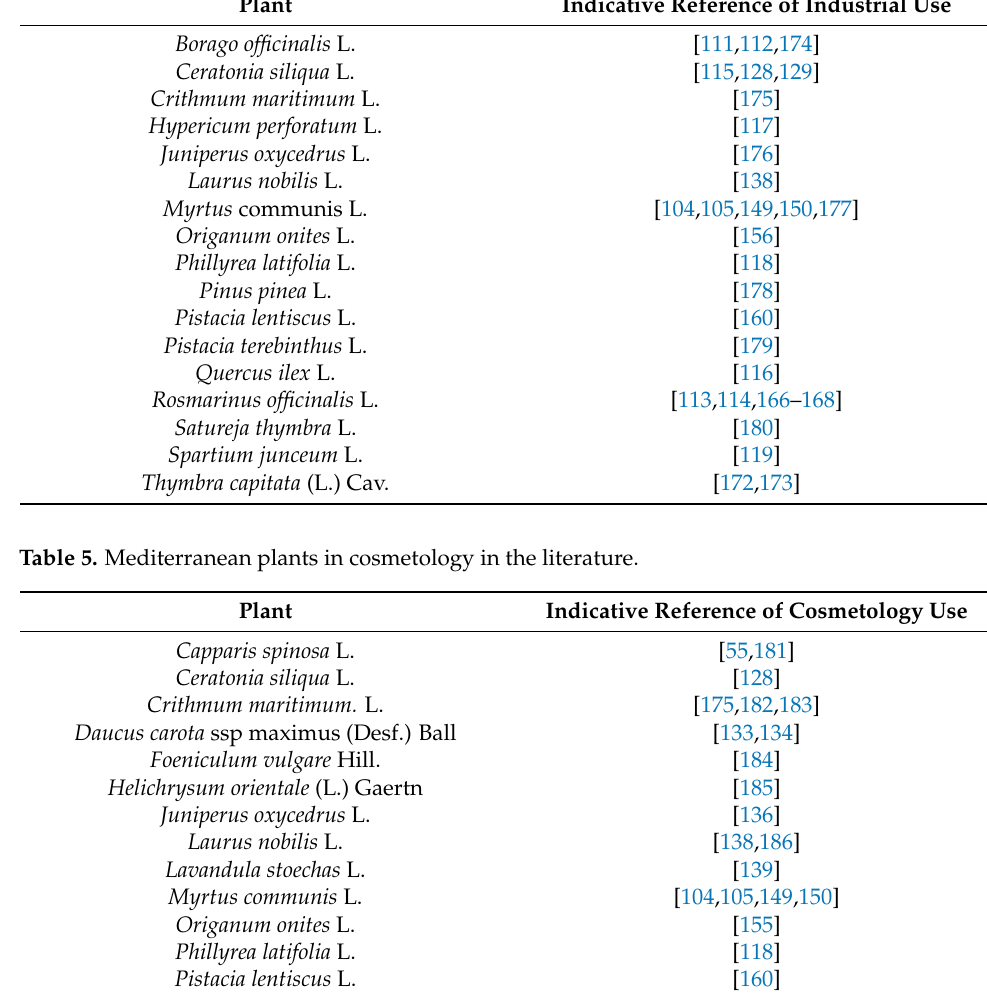
Table 4. Industrial use of Mediterranean plants in the literature. Plant